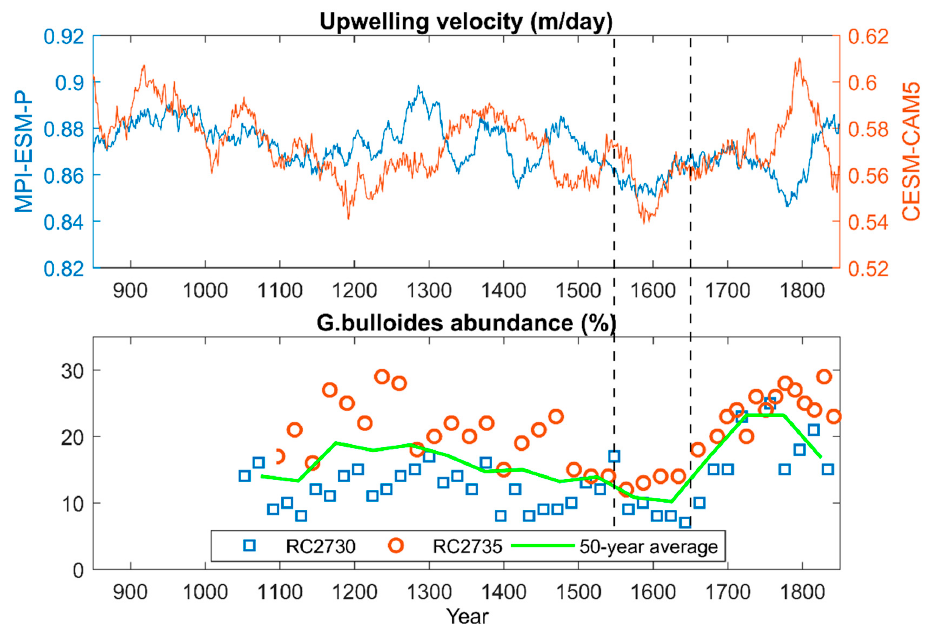
Figure 9. Upwelling velocity modeled by MPI-ESM-P (blue) and CESM-CAM5 (red) for the last millennium (upper) and replotted using data of Anderson et al. (2002) for the G. bulloides abundance (lower). The blue and red markers show the data from two sediment records located very closely in the western Arabian Sea, RC2730 and RC2735, respectively. The green line is the average of all the records in a block of 50 years. The dashed black lines show the period where the “flip” is detected.